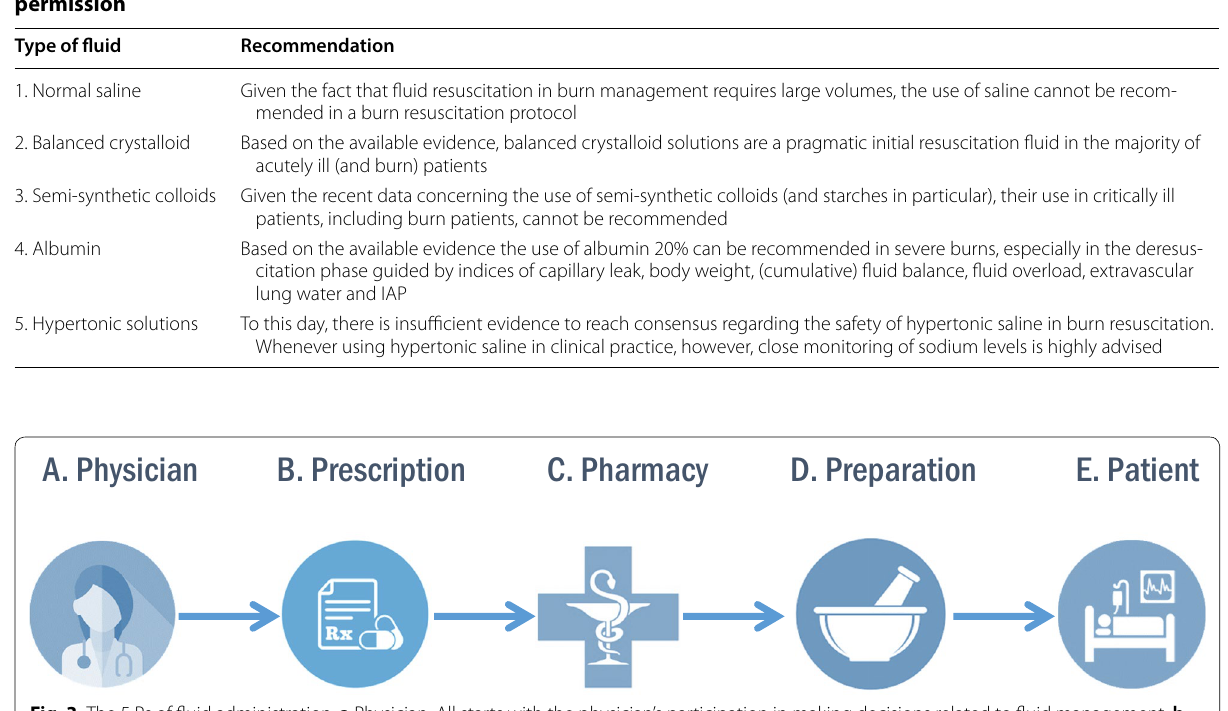
Fig. 3 The 5 Ps of fluid administration. a Physician: All starts with the physician’s participation in making decisions related to fluid management. b Prescription: The physician should engage in writing a prescription that accounts for drug, dose, duration and whenever possible de-escalation. c Pharmacy: The prescription is sent to the pharmacy and is checked for inconsistencies by the pharmacist to get a more holistic view. d Preparation: The process by which the prescription is prepared and additions (e.g., electrolytes) made. e Patient: The filled prescription goes back to the patient and fluid stewards should observe administration, response, and